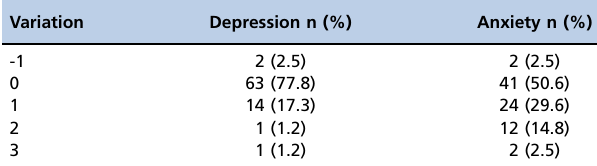
Table 6 - Variation in the intensities of depression and anxiety with oxybutynin treatment